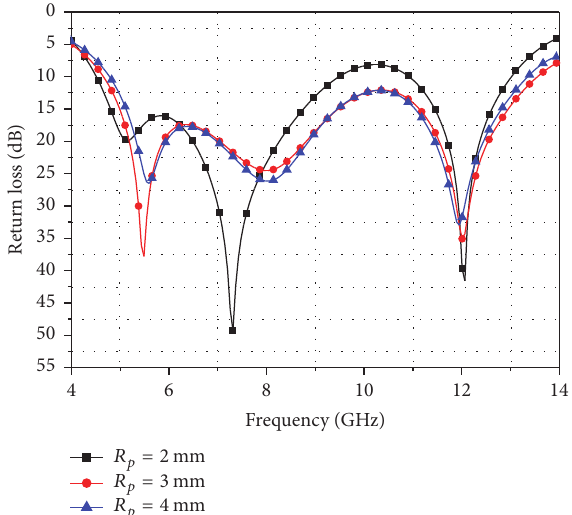
Figure 8: Simulated return loss against frequency for the proposed defected substrate wideband antenna with various 𝑅 𝑝 ; other param- eters are the same as listed in Table 1.